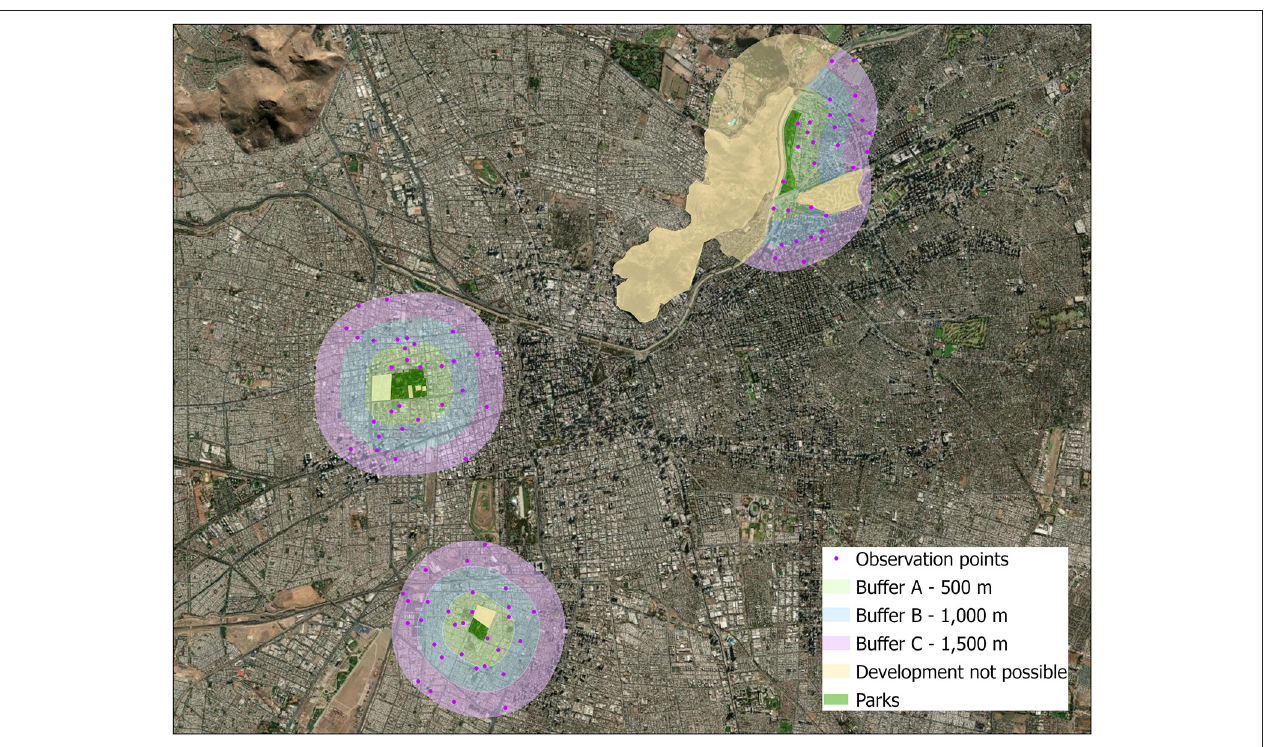
FIGURE 6 | Map of study area in Santiago with buffers and observation